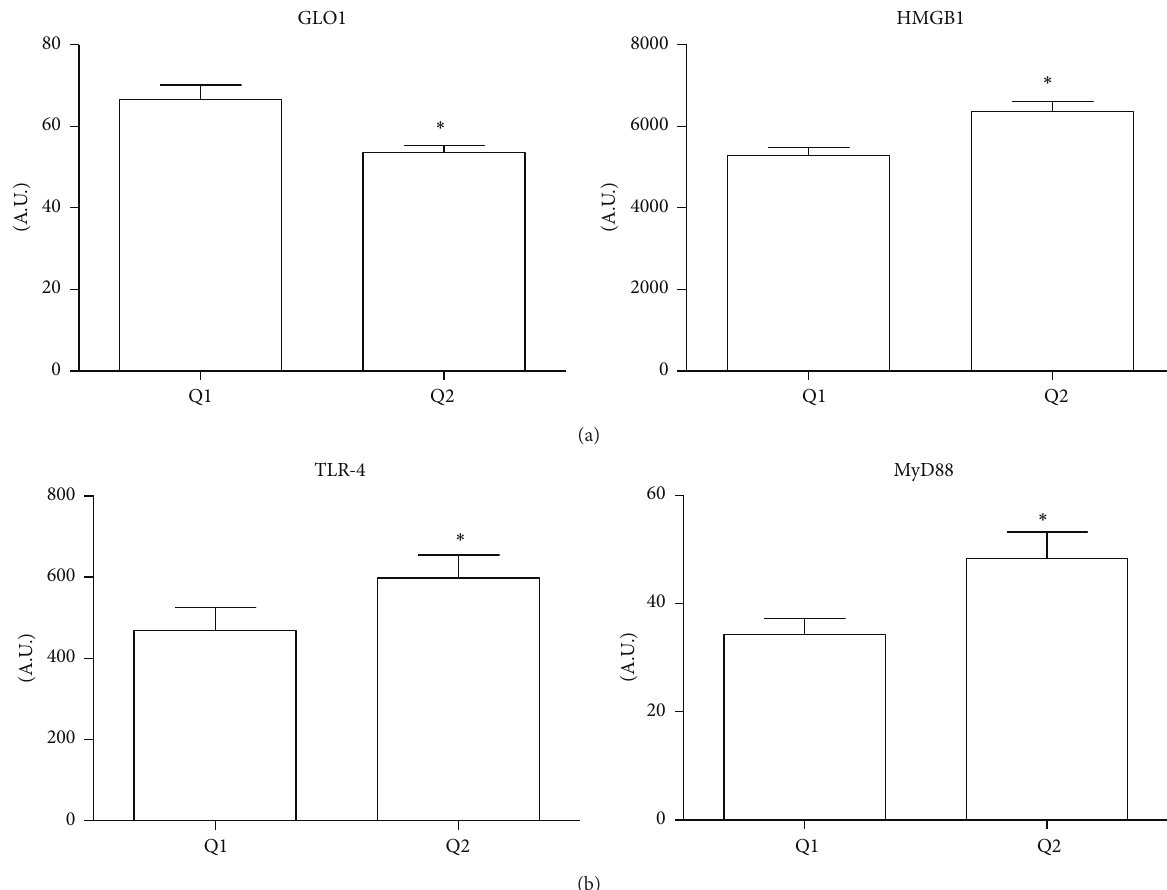
Figure 3: Relationship between RAGE expression in EAT and EAT inflammation. CAD patients were stratified into two groups (Q1 and Q2) on the basis of the median RAGE expression in EAT. (a) Gene expression of GLO1 and HMGB1 in EAT was compared in the two groups; (b) TLR-4 and MyD88 levels were compared in the two groups. A.U.: arbitrary unit. Data are expressed as mean ± SD; ∗ 𝑝 < 0.05